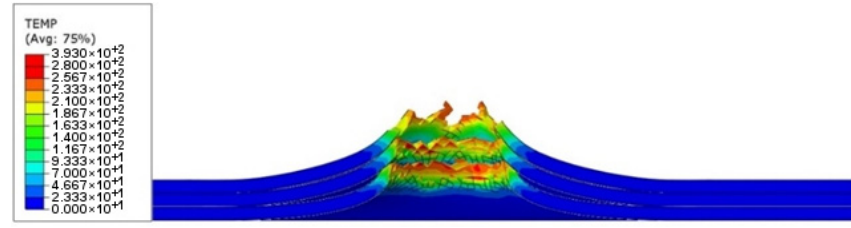
Figure 28. Temperature increment visualization due to the puncture of three layers of titanium alloy sheet by striker—section view.